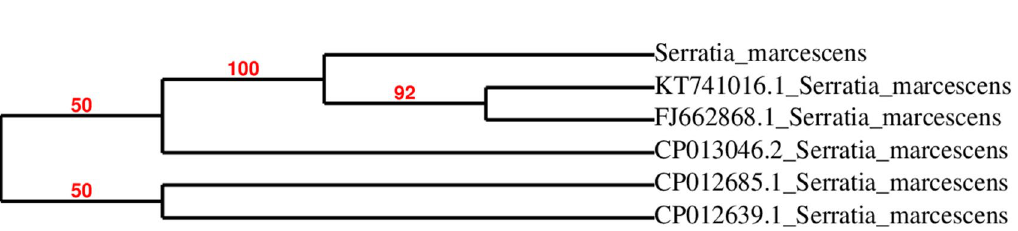
Fig. 3. Neighbour-joining phylogenetic representation of the strains A 2 and their closest relatives based on 16S rRNA gene sequences. Dendrogram constructed by maximum-likelihood method using PhyML 3.0 aLRT.